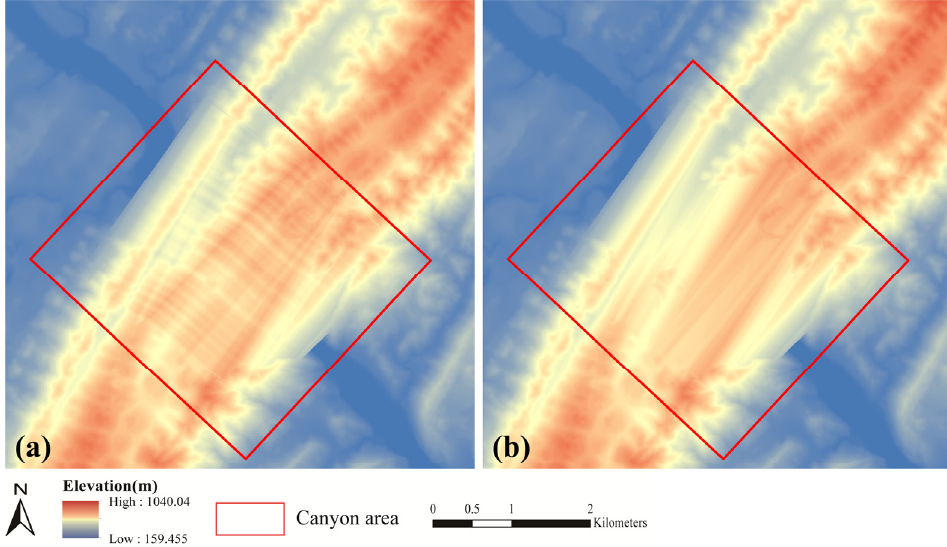
Figure 17. Different types for restoring the palaeotopography of the transverse canyon ③ . ( a ) The fixed result of the three-edge type, and ( b ) the fixed result of the two-opposite-edge type.